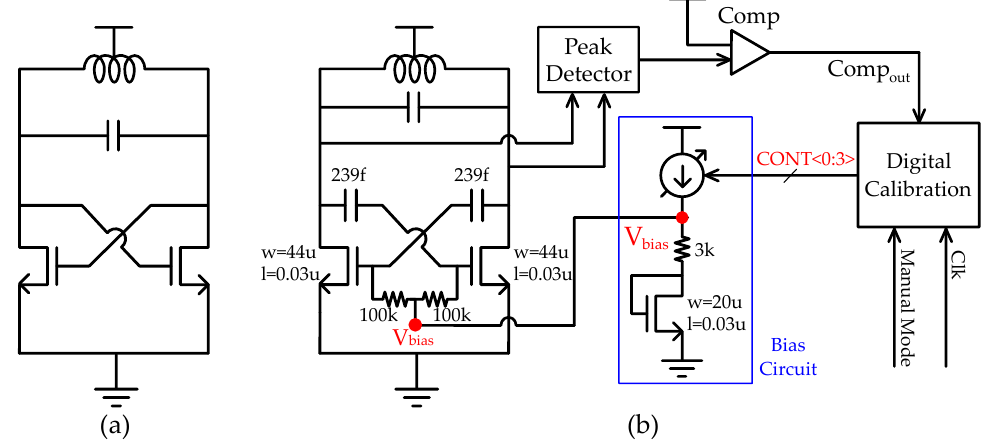
Figure 1. ( a ) VCO structure for Class-B operation; ( b ) entire block diagram of proposed Class-C VCO